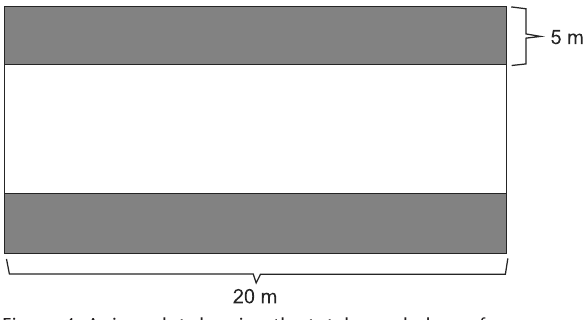
Figure 4. A river plot showing the total sampled area for anurans, including margins (gray) and river channel